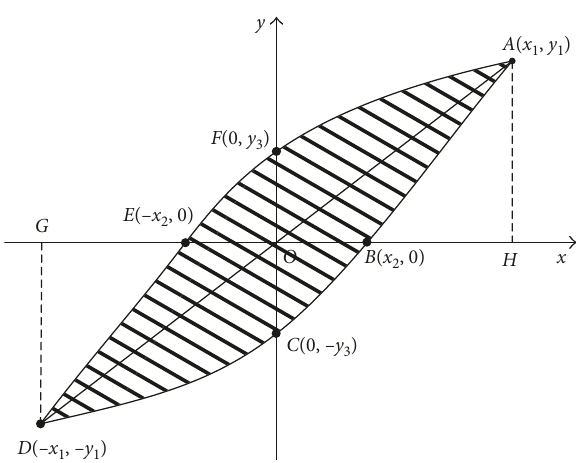
Figure 6: Hysteretic energy dissipation in the